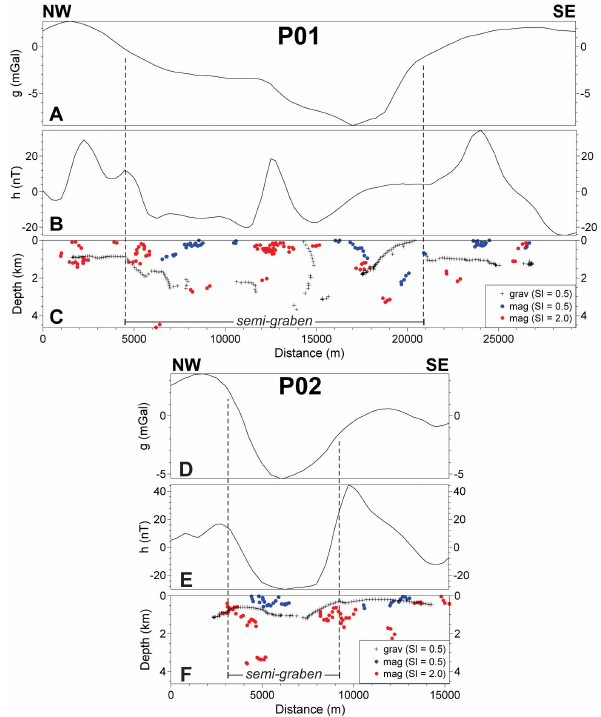
Figure 7. Gravity (a, d) and magnetic (b, e) anomalies and Euler solutions (c, f) of profiles P01 (top) and P02